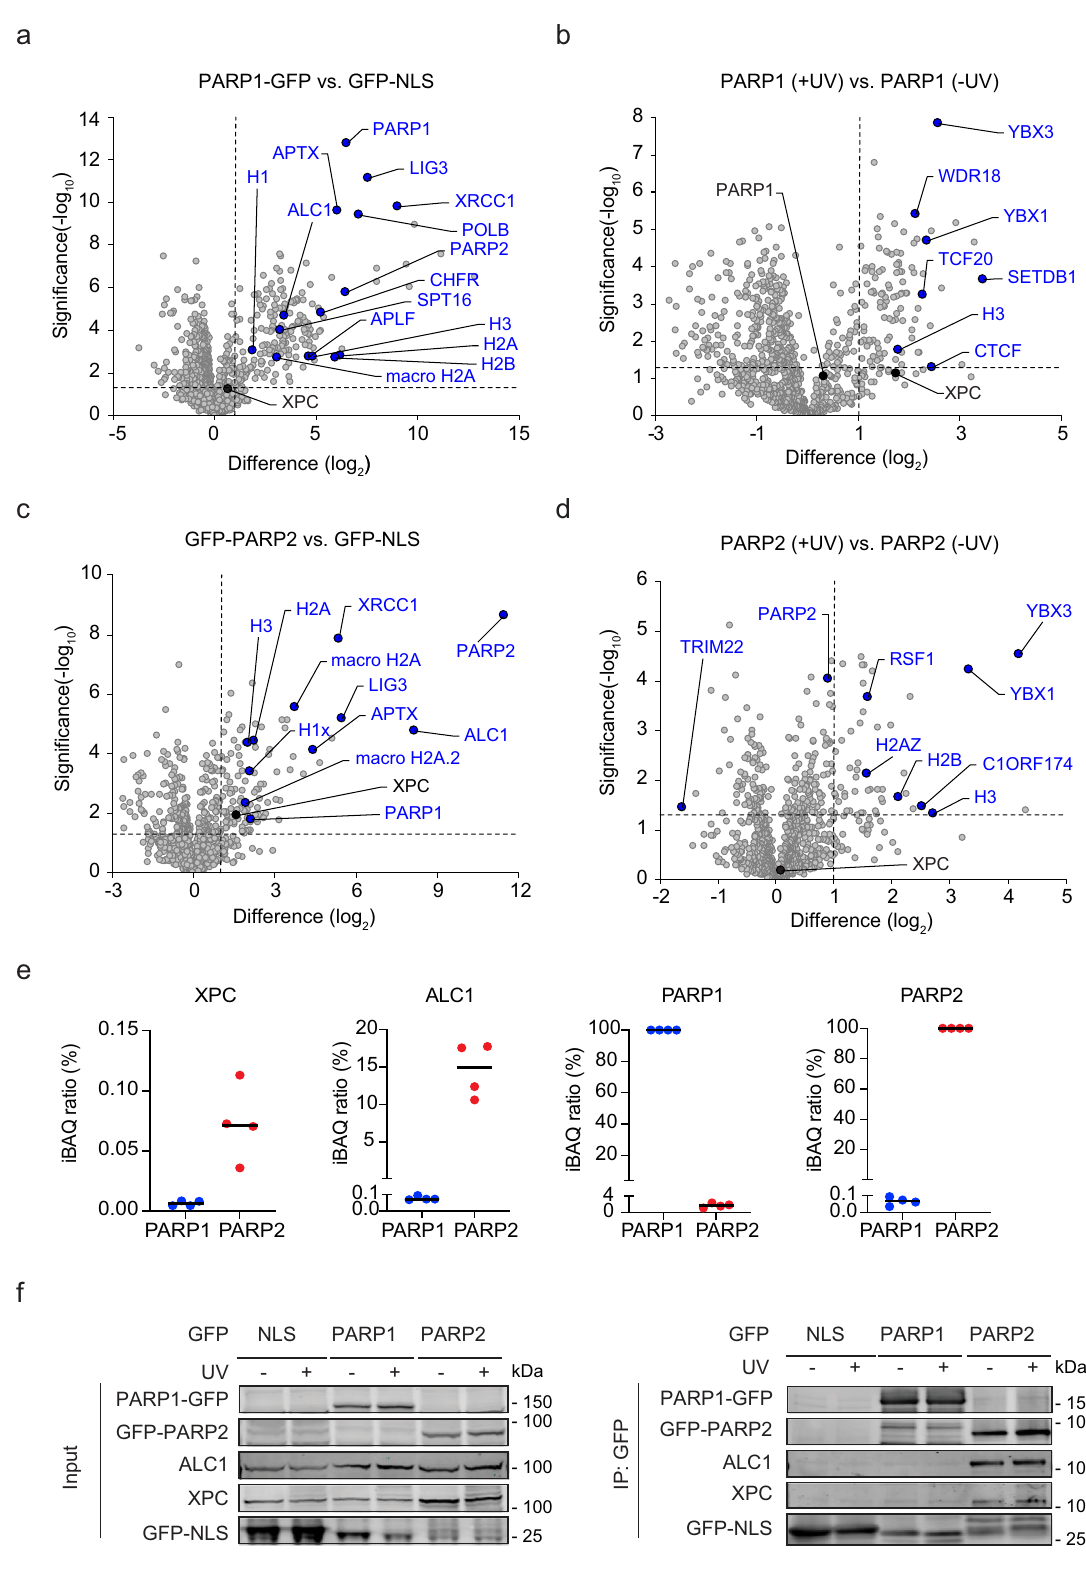
rapid recruitment of PARP1-GFP to sites of DNA damage within seconds, after which steady-state bound levels decreased in the fi rst several minutes (Fig. 3a, b). GFP-PARP2 was also recruited to UV-C laser damage. Steady-state bound levels remained high for ~10 min without an apparent decrease